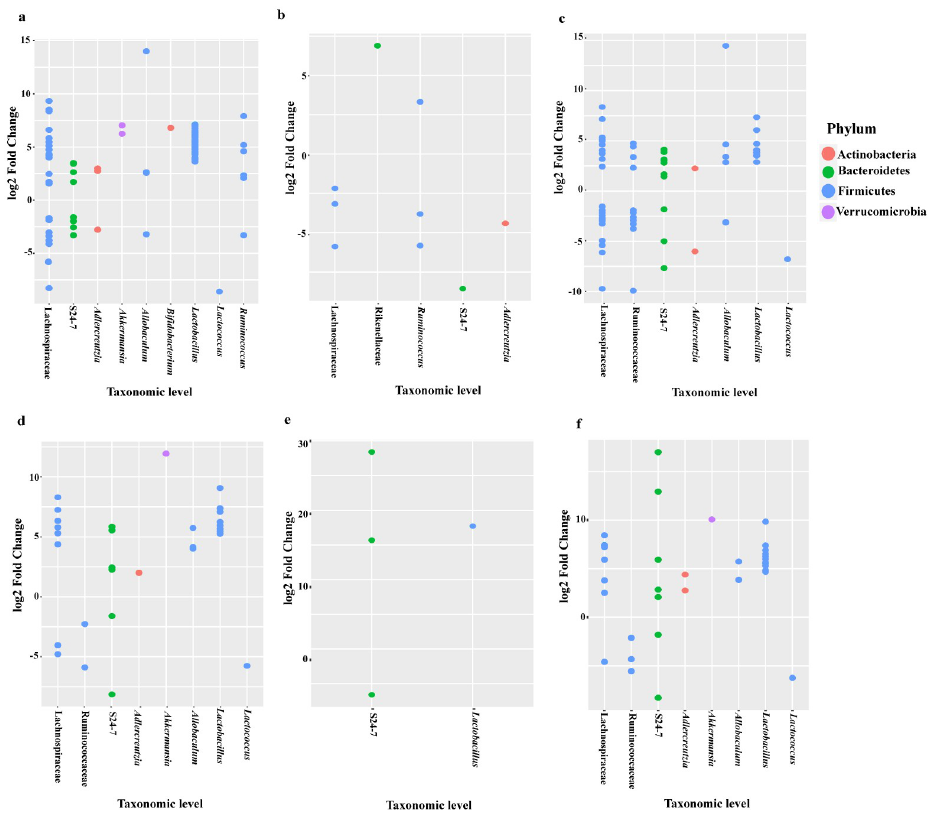
Fig 4. Log2 fold change of relative abundance of microbial species in mice before the onset of tumor. (a) Dotplot of the bacterial abundance between BSp-fed and control-fed mice, (b) GTPs-fed and control-fed mice, (c) combination- fed and control-fed mice before the onset of tumor in the BE group (n = 8), (d) Dotplot of the microbial species abundance between BSp and control, (e) GTPs and control, (f) combination and control dietary treatment before the onset of tumor in the LC group (n =